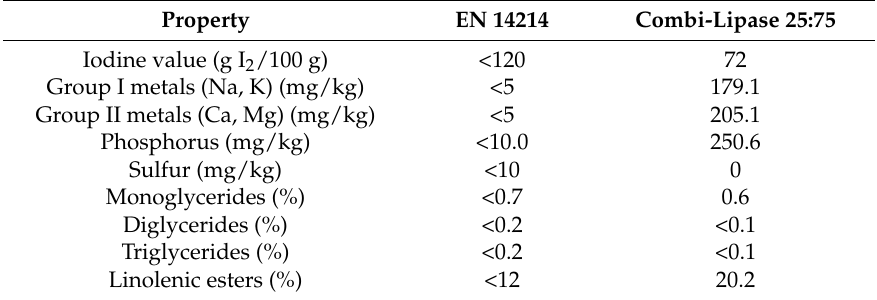
Table 7. Biodiesel properties obtained by the combi-lipase 25:75 SBA-15-NH 2 G-CalB:SBA-15-NH 2 G-PC.